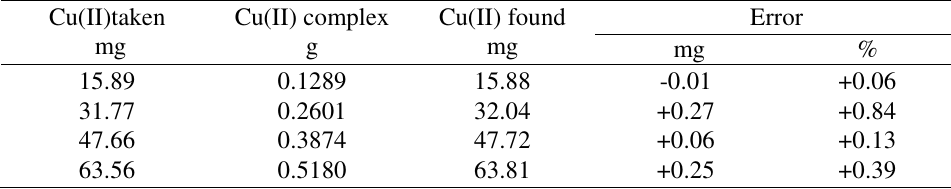
Table - 1. Result of gravimetric estimation of copper (II) at pH 5.0;